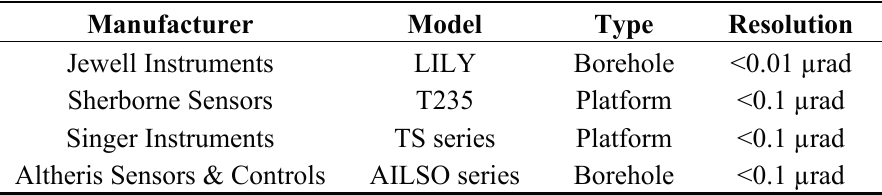
Table 2. High-precision tiltmeters.